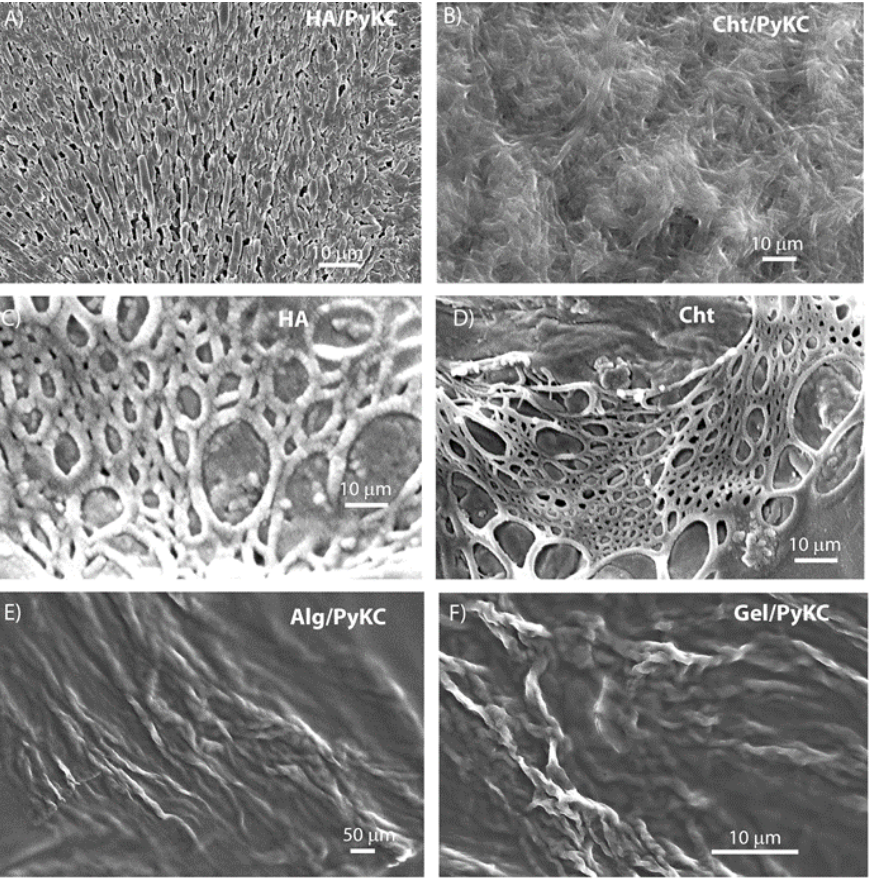
Figure 1. FESEM images of different hydrogels. ( A ) HA/PyKC (10:1 wt%); ( B ) Cht/PyKC (10:1 wt %); ( C ) HA (10 wt %); ( D ) Cht (10 wt %); ( E ) Alg/PyKC (10:1 wt %); and ( F ) Gel/PyKC (1:1 wt %).